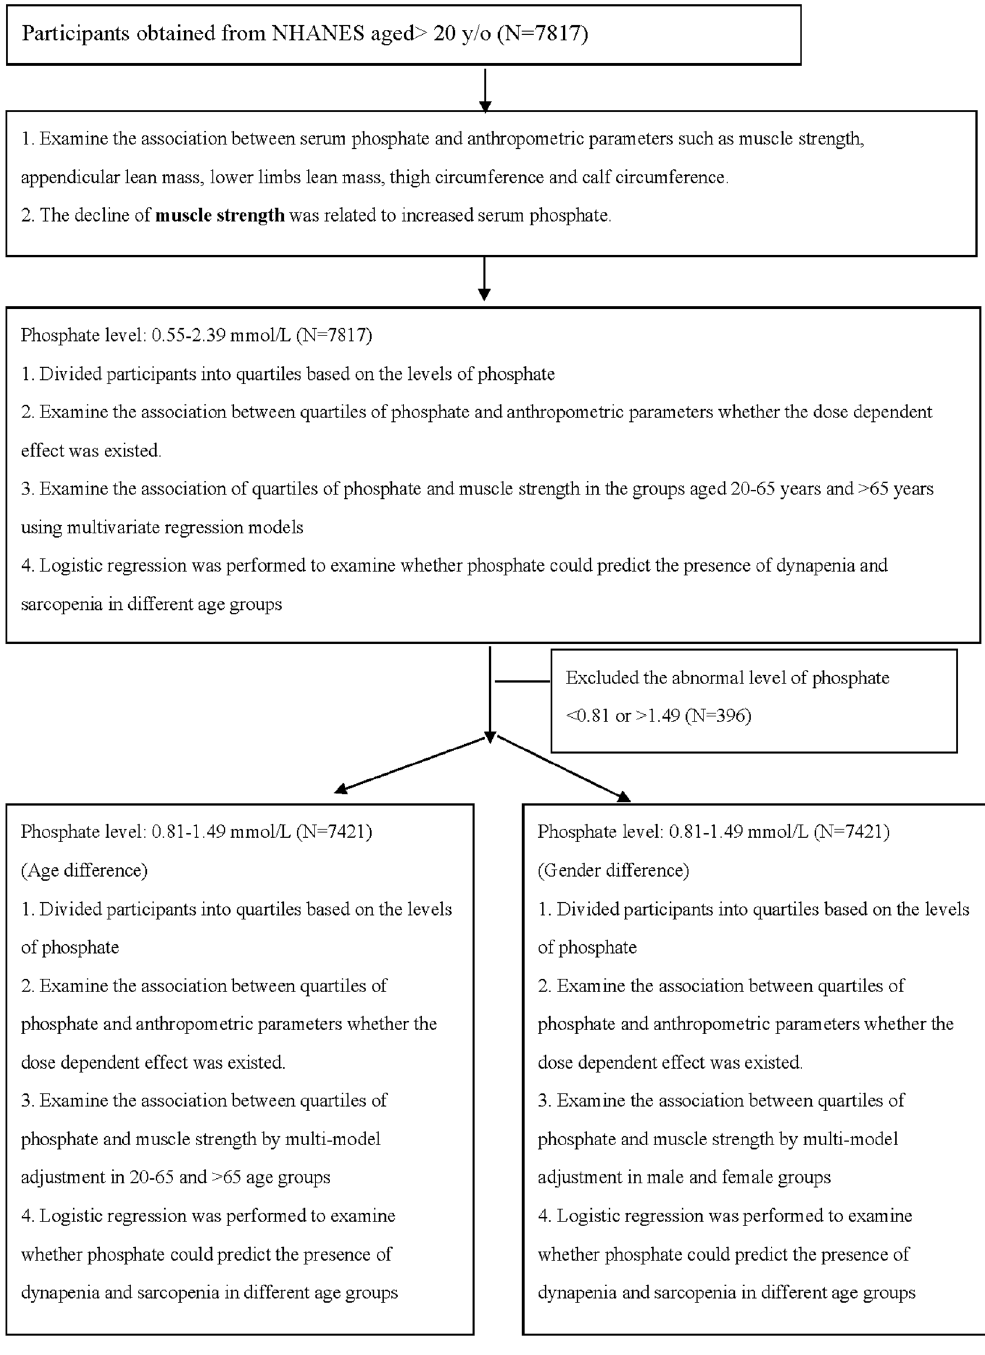
Figure 1. Study flow